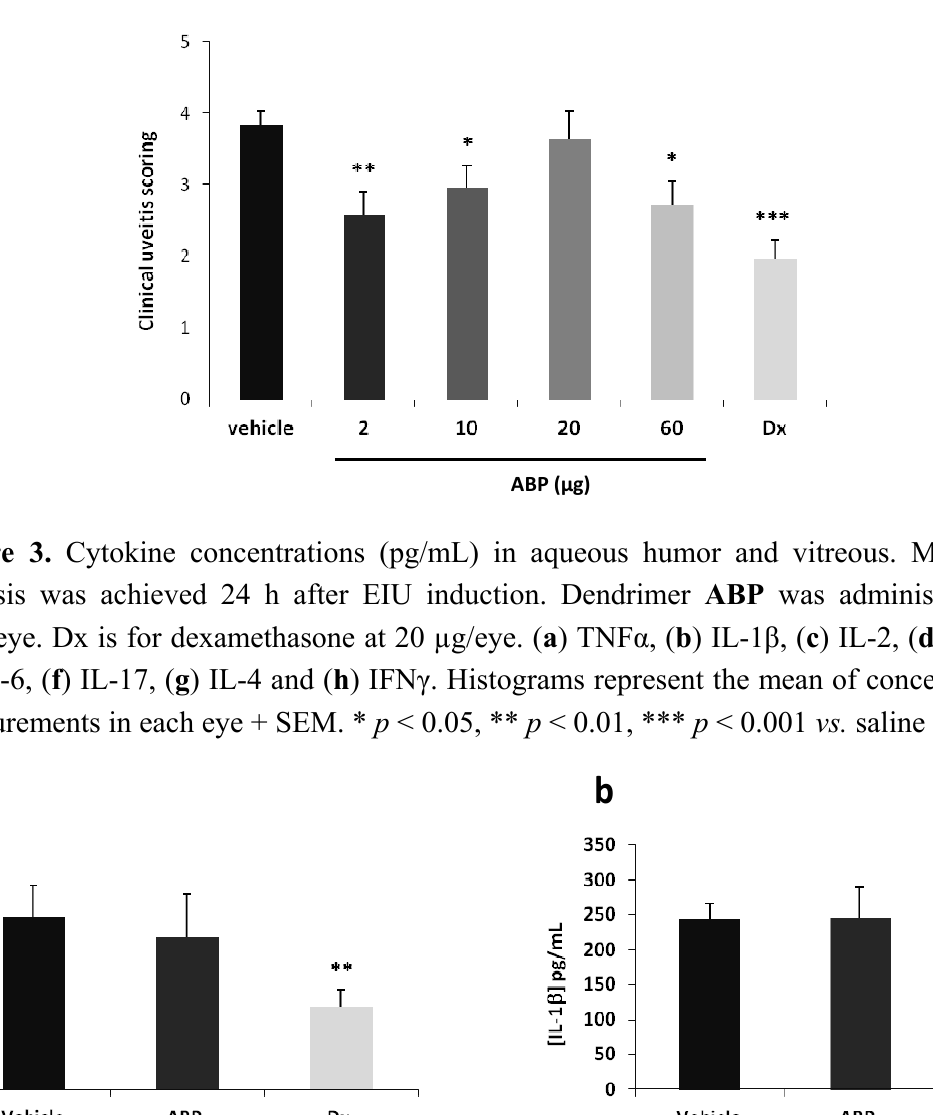
Figure 2. Clinical scoring 24 h after EIU induction and intra-vitreal dendrimer ABP administration. Dx is for dexamethasone at 20 µg/eye. Histogram bars represent the mean clinical scoring (arbitrary units) + SEM. * p < 0.05, ** p < 0.01, *** p < 0.001 vs. saline vehicle.